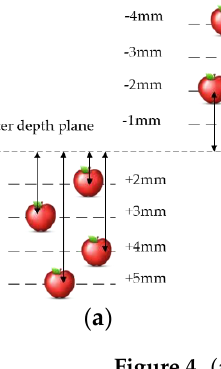
Figure 5. Different views of the 3D image reconstructed by the proposed prototype. ( a ) Left view, ( b ) center view, and ( c ) right view.